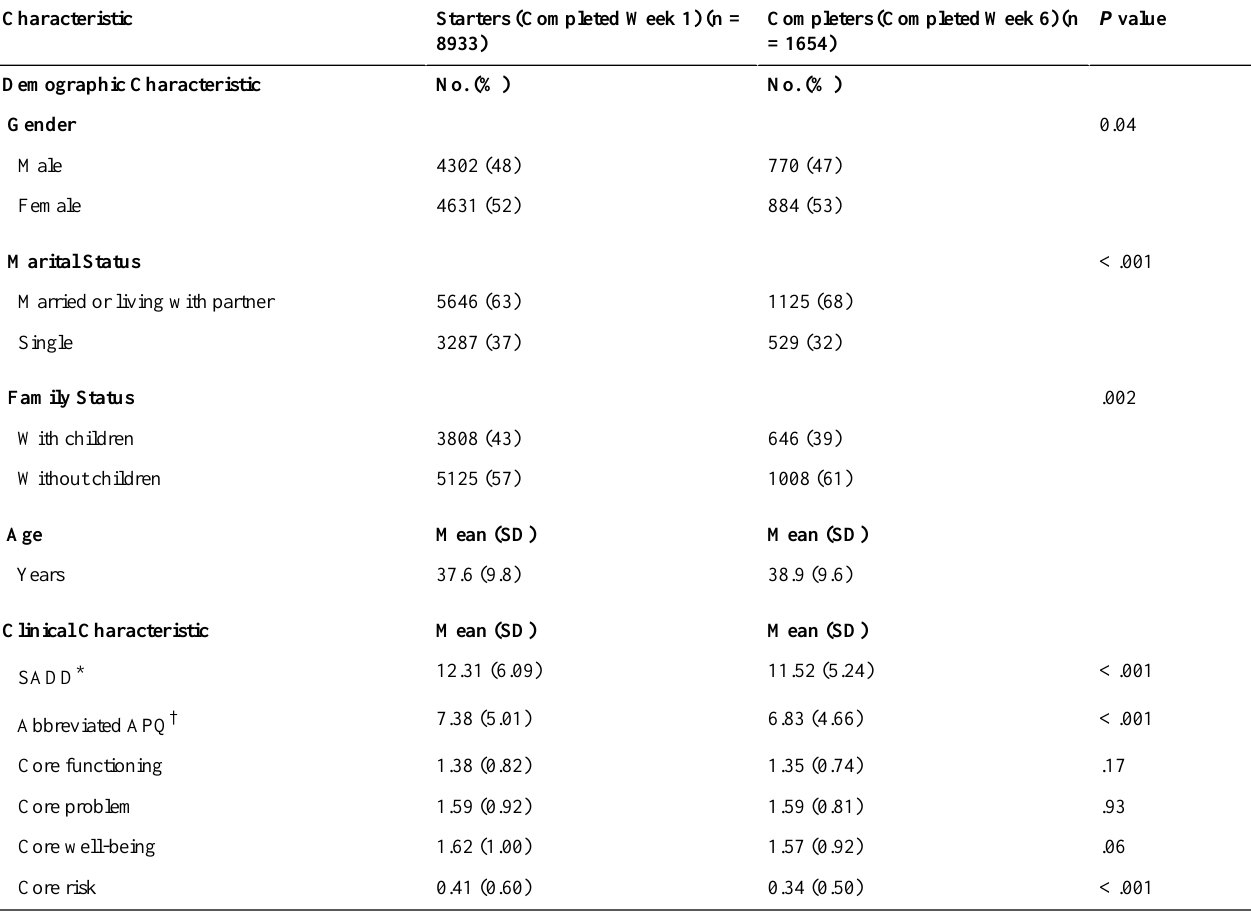
Table 3. Comparison of baseline demographic and clinical characteristics of those who completed the six week program (completers) with those who only completed the first week of the program (starters)